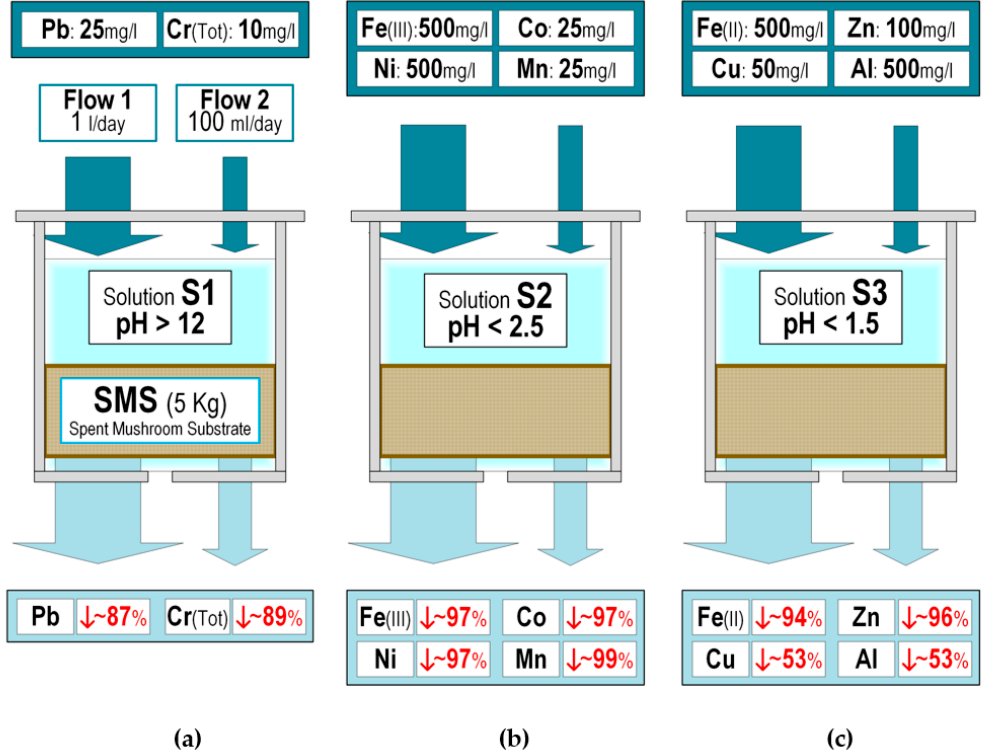
Figure 9. Removal efficiency (%) of the heavy metals that were analysed. Dissolution groups S1 ( a ), S2 ( b ) and S3 ( c Figure 9. efficiency (%) of the heavy metals that were analysed.